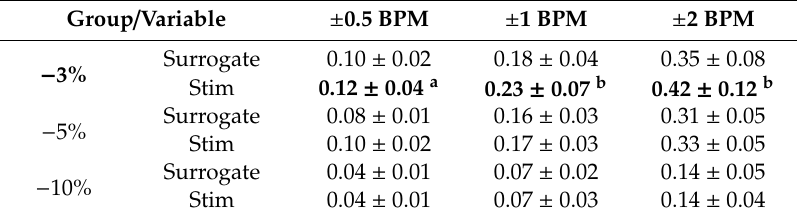
Table 3. Summary of the synchronization ratio under each set of stimulation conditions.